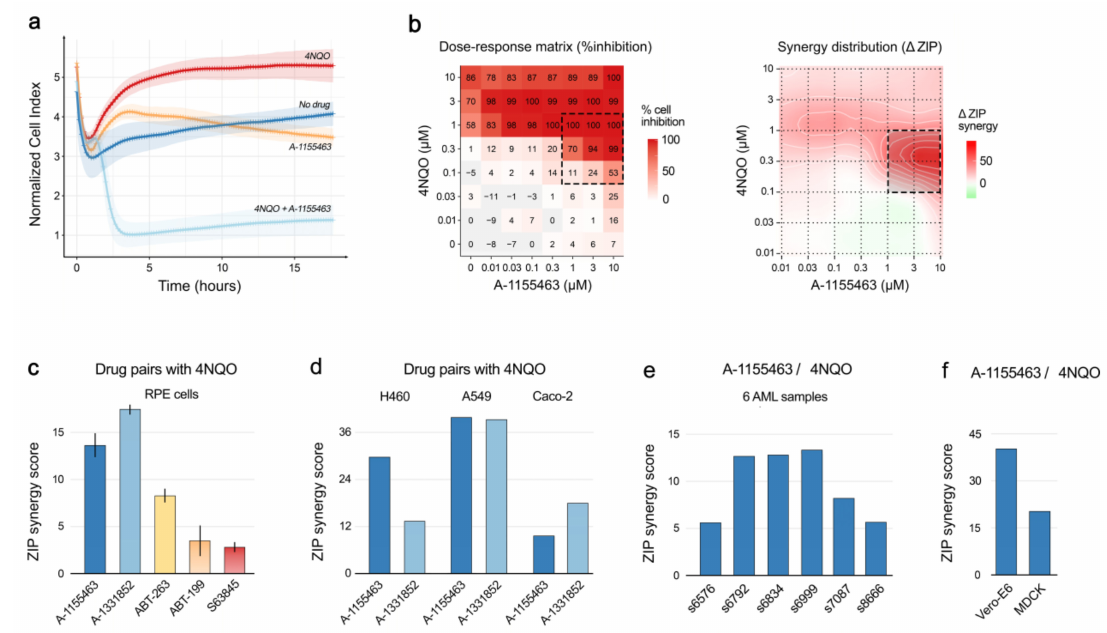
Figure 3. Combination of DNA-damaging agent 4NQO with Bcl-xL-, but not Bcl-2- or Mcl-1-specific inhibitors, exhibit synergistic toxicities on human non-malignant RPE, cancer A549, H460, Caco-2 and mononuclear cells (MNCs) isolated from AML patients as well as on monkey Vero-E6 and dog MDCK cells. ( a ) Real-time impedance traces for RPE cells exposed to 1 µ M 4NQO, 1 µ M A-1155463 or their combination. Control trace represents cells exposed to 0.1% DMSO (Mean ± SD; n = 8). ( b ) The interaction landscapes of A-1155463-4NQO combination. It represents the net combinational e ff ects on viability of RPE cells, as measured with CTG assays. ( c ) Synergy scores of combinations of 4NQO and 5 Bcl-2 inhibitors on RPE cells (Mean ± SD; n = 3). Cells were treated with increasing concentrations of a Bcl-2 inhibitor and 4NQO. After 24 h cell viability was measured using the CTG assay. Synergy scores were quantified based on the ZIP model. ( d ) Synergy scores for combinations of 4NQO and 2 Bcl-xL inhibitors on human cancer A549, H460, Caco-2 cells. Cells were treated with increasing concentrations of a Bcl-xL inhibitor and 4NQO. After 24 h cell viability was measured using the CTG assay. Synergy scores were quantified based on the ZIP model. ( e ) Synergy scores for 4NQO- A-1155463 combination on MNCs. Cells were treated with increasing concentrations of a A-1155463, 4NQO or both agents. After 24 h cell viability was measured using the CTG assay. Synergy scores were quantified based on the ZIP model. ( f ) Synergy scores for 4NQO-A-1155463 combination for Vero-E6 and MDCK cells. Cells were treated with increasing concentrations of a A-1155463, 4NQO or both agents. After 24 h cell viability was measured using the CTG assay. Synergy scores were quantified based on the ZIP